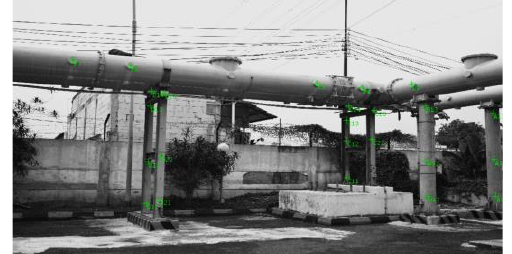
Figure 11. Target points marking in Australis 6